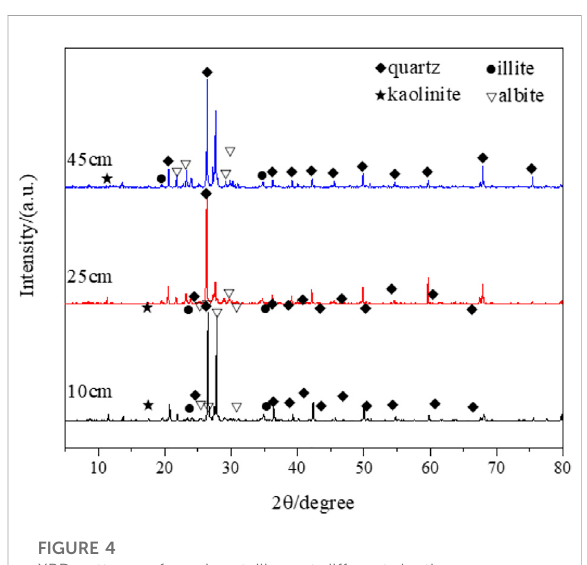
FIGURE 4 XRD patterns of uranium tailings at different